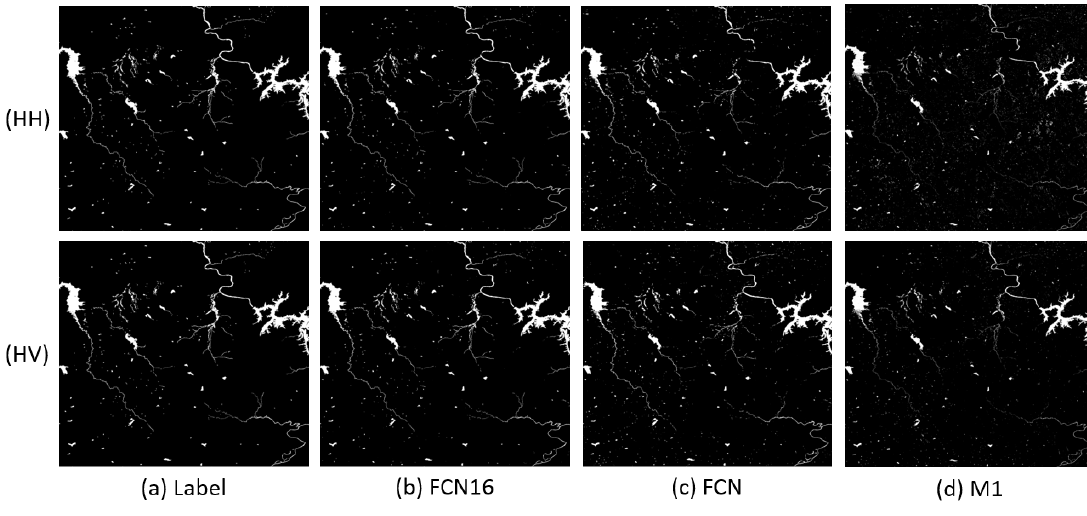
Figure 6. Results comparison of Scene 2: ( a ) Label; ( b ) FCN16; ( c ) FCN; and ( d )